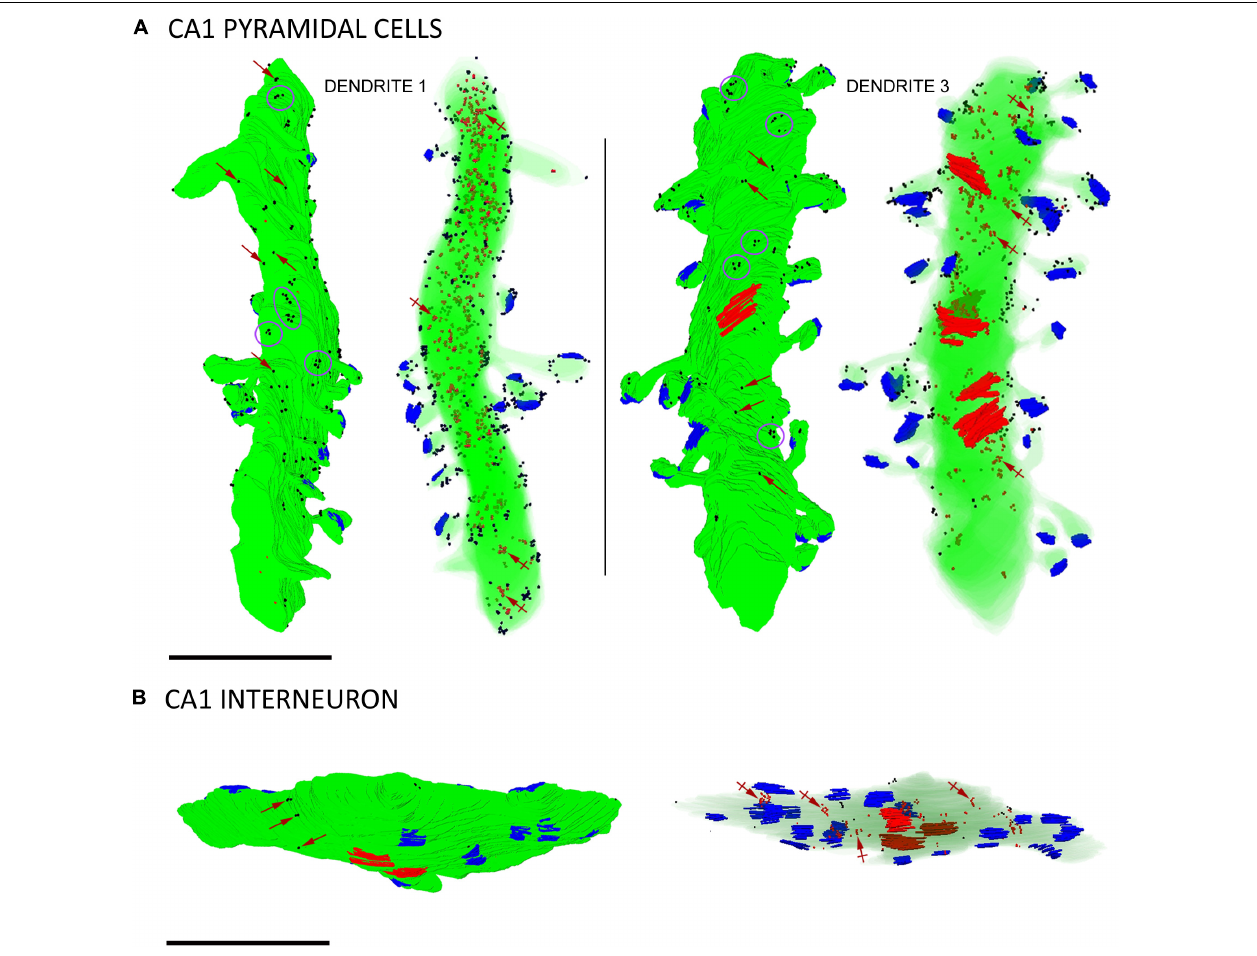
FIGURE 4 | Three-dimensional reconstructions of SK2-immunopositive dendrites. (A) Two examples of reconstructed dendritic segments of CA1 pyramidal cells in the stratum radiatum immunolabelled for SK2. Dendrite 1 was reconstructed from 147 sections and dendrite 3 from 171 sections. For each dendrite, the left 3D reconstructions show SK2 immunoparticles (black dots) on the surface and the right show SK2 immunoparticles (red dots, a few indicated by crossed arrows) at intracellular sites. To visualize immunoparticles on the surface, the dendritic shaft and spines are shown in solid green. To visualize intracellular labeling the surface of dendrites are shown with transparency. Excitatory synapses on spines are shown in blue and inhibitory synapses on shafts in red. Immunoparticles for SK2 were found either isolated (red arrows) along the plasma membrane or forming clusters (purple ellipses/circles). (B) Example of a reconstructed dendritic segment of interneuron immunolabelled for SK2. The left and right 3D reconstructions show SK2 immunoparticles in the surface (black dots) and at intracellular sites (red dots, a few indicated by crossed arrows), respectively. Excitatory synapses on the shafts are shown in blue and inhibitory synapses in red. This dendrite was reconstructed from 88 sections and contained 18 excitatory and 3 inhibitory synapses. Few immunoparticles for SK2 were found along the plasma membrane isolated (purple arrows) along the plasma membrane, and most were distributed at intracellular sites. Scale bar: (A,B) 1 µ m.